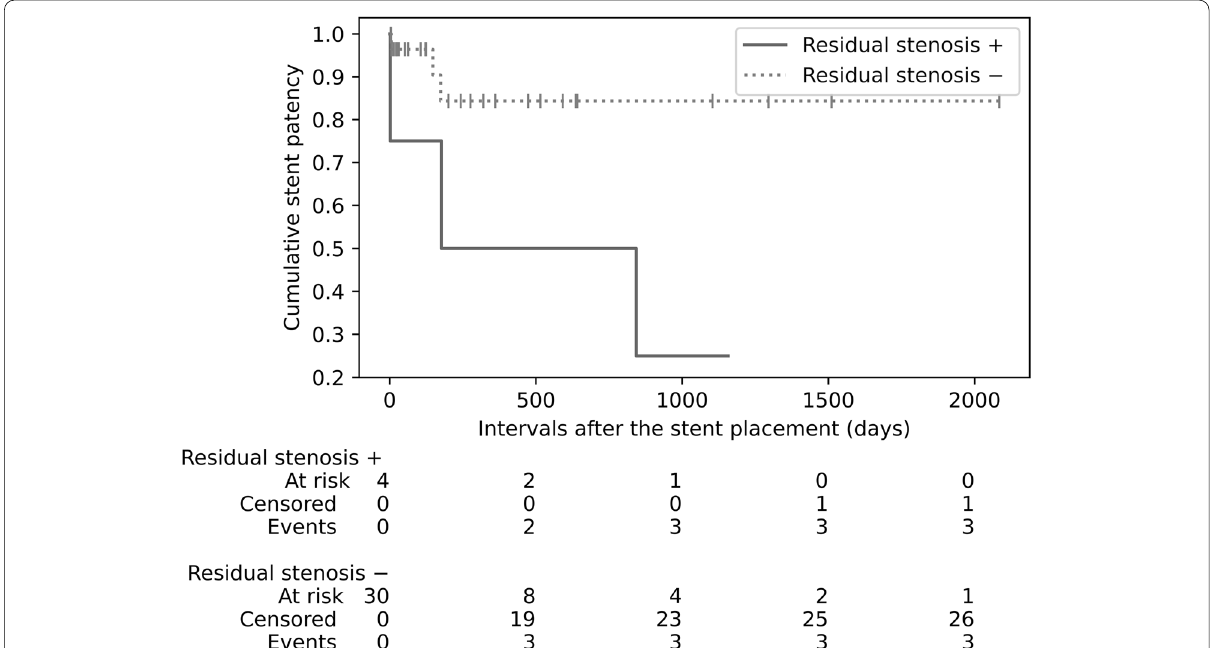
Fig. 3 Comparison of cumulative stent patency in patients with and without residual stenosis after stent placement. The black plot shows the cumulative stent patency rate in patients with residual stenosis after stent placement. The gray dotted plot shows the cumulative stent patency rate in patients without residual stenosis after stent placement. The vertical lines on the gray plot represent censoring. The figures at the bottom count the cumulative number of patients at risk, censored, and with stent